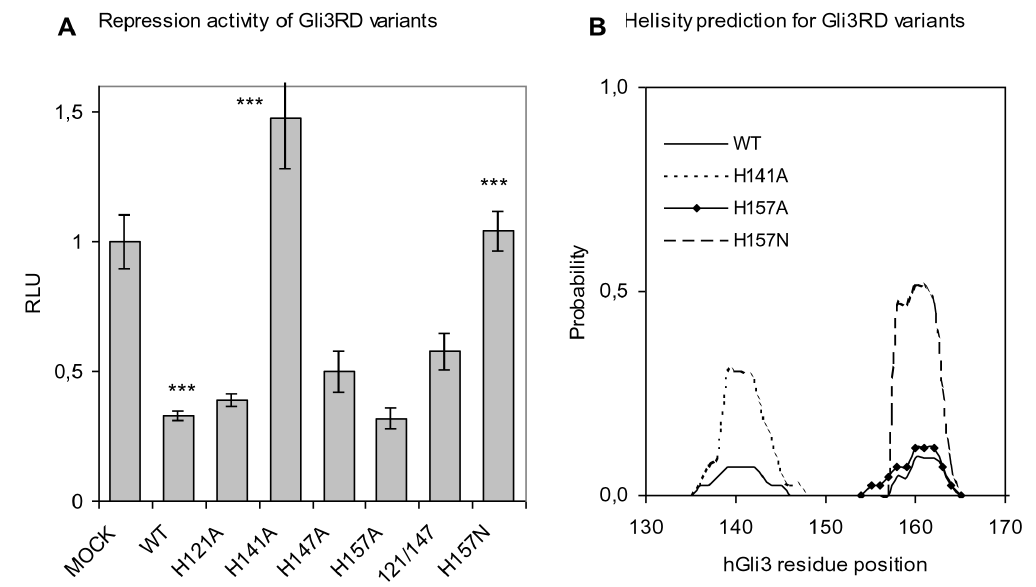
Figure 4. The luciferase reporter activity together with different Gli3RD variants. (A) All Gli3RD constructs were expressed as Gal4 DBD fusions in HEK293 cells and their repressor activity is compared to that of Gal4 DBD alone (mock). The activity of Gla4-Gli3RD is shown as WT. The analyses were performed three to five times and error bars show standard deviations. Statistically significant were WT vs MOCK, WT vs H141A and WT vs H157N, p , 0,001, One-Way ANOVA with Dunnett’s Multiple Comparisons Test. (B) The Agadir prediction of helical behaviour for Gli3RD